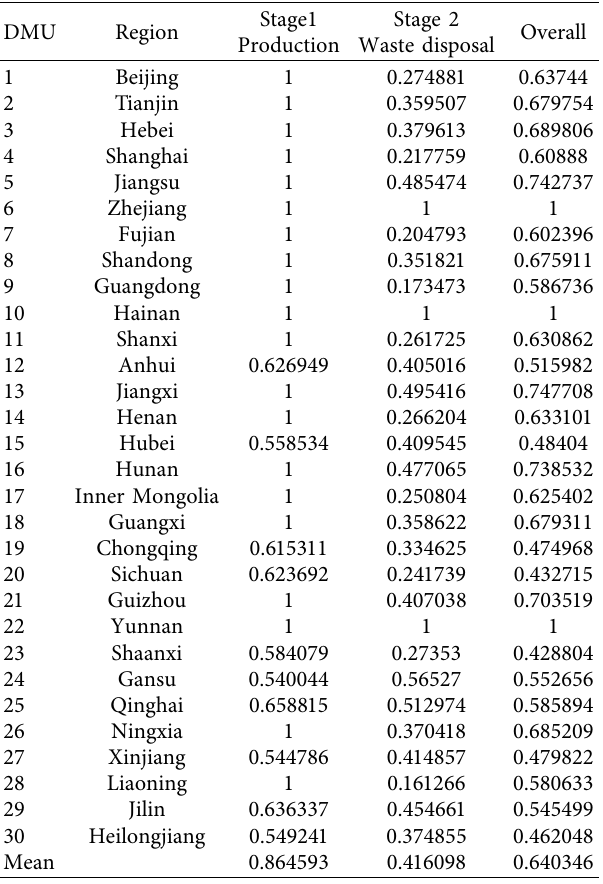
Table 4: Efficiency evaluation of 30 regions in China. Table 5: Pearson correlation coefficient test